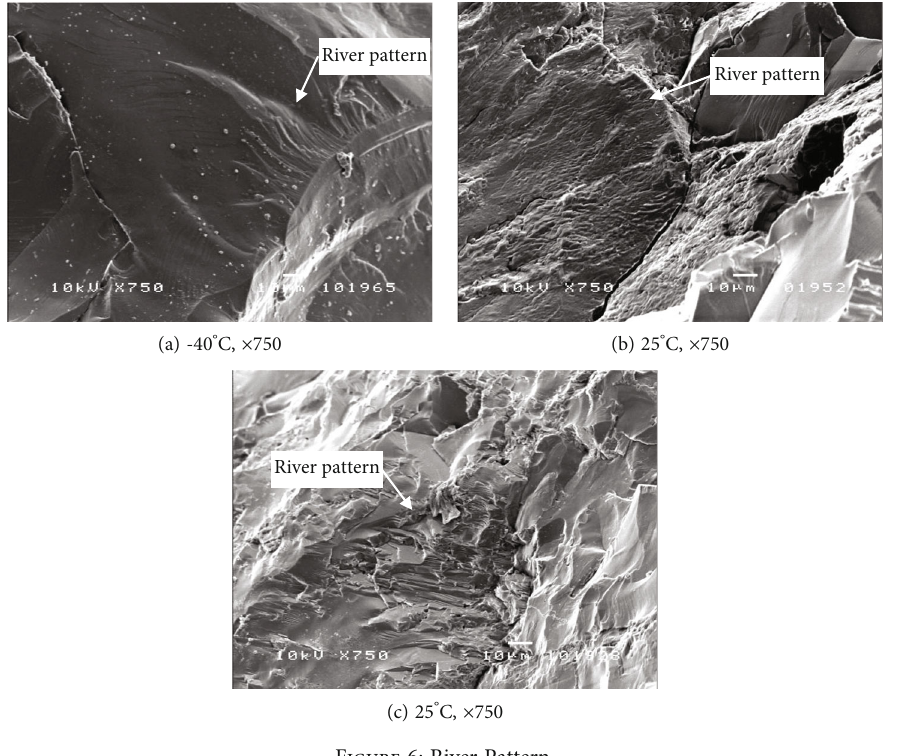
Figure 6: River Pattern.